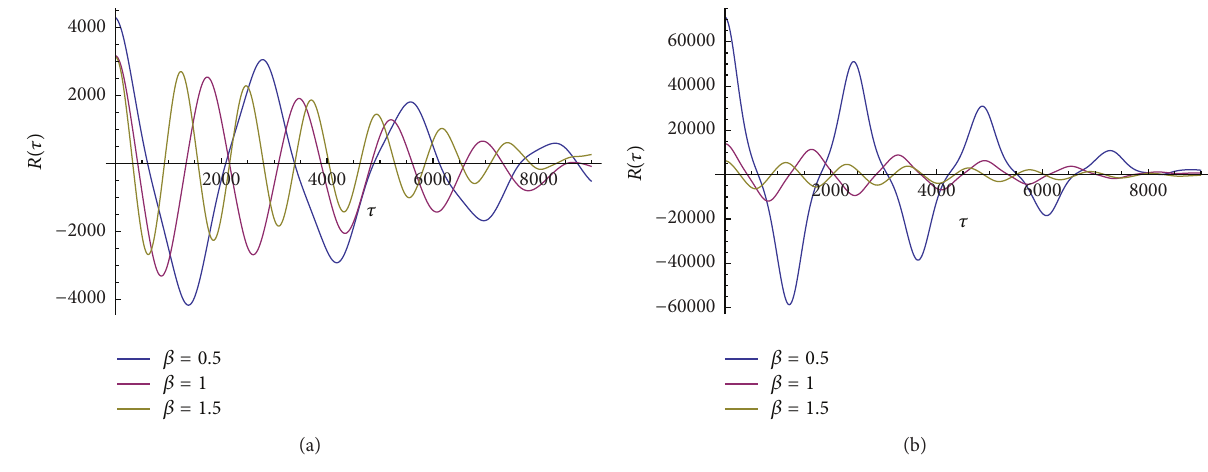
Figure 7: Autocorrelation displays of (a) TNDES and (b) GNDES.